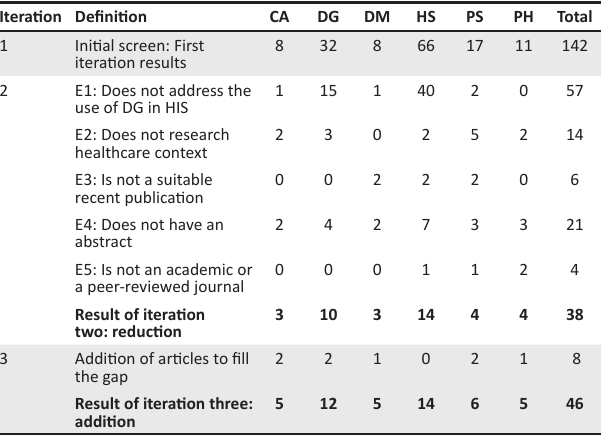
TABLE 1: List of iterations for inclusion criteria. Iteration